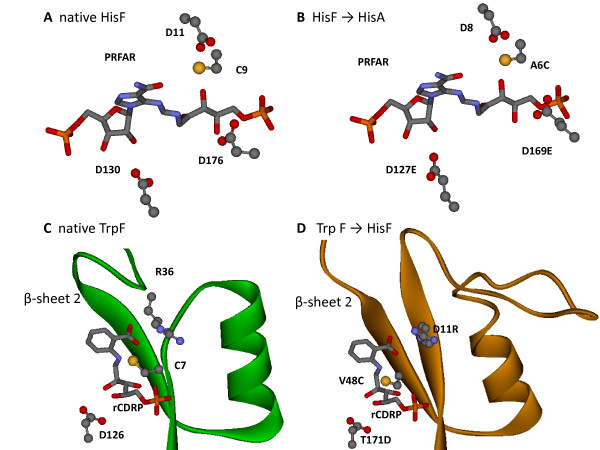
Comparison of wild-type active sites with transfer models HisF(template) → HisA(scaffold) and TrpF(template) → HisF(scaffold) determined by TransCent. The catalytic residues in native HisF (A, 1thf) and the designed residues of the HisF → HisA transfer (B) are shown in complex with PRFAR (HisF substrate and HisA product). The designed residues in the HisA scaffold are located at equivalent positions as in the HisF template (compare panel B and A). The catalytic residues in native TrpF (C, 1lbm) and the corresponding residues of the designed TrpF → HisF model (D) are shown in complex with rCdRP (product analogue of TrpF). In wild-type TrpF, Cys 7 is located on β-sheet 1, and Arg 36 is located on a long loop after β-sheet 2. In the model, an arginine residue, which is responsible for ligand binding, is placed in the elongated β-sheet 1 (D11R exchange), whereas the catalytic cysteine (V48C exchange) is located in β-sheet 2. The aspartic acid D126 (TrpF) and the designed exchange T171D (TrpF → HisF transfer) are located at equivalent positions.